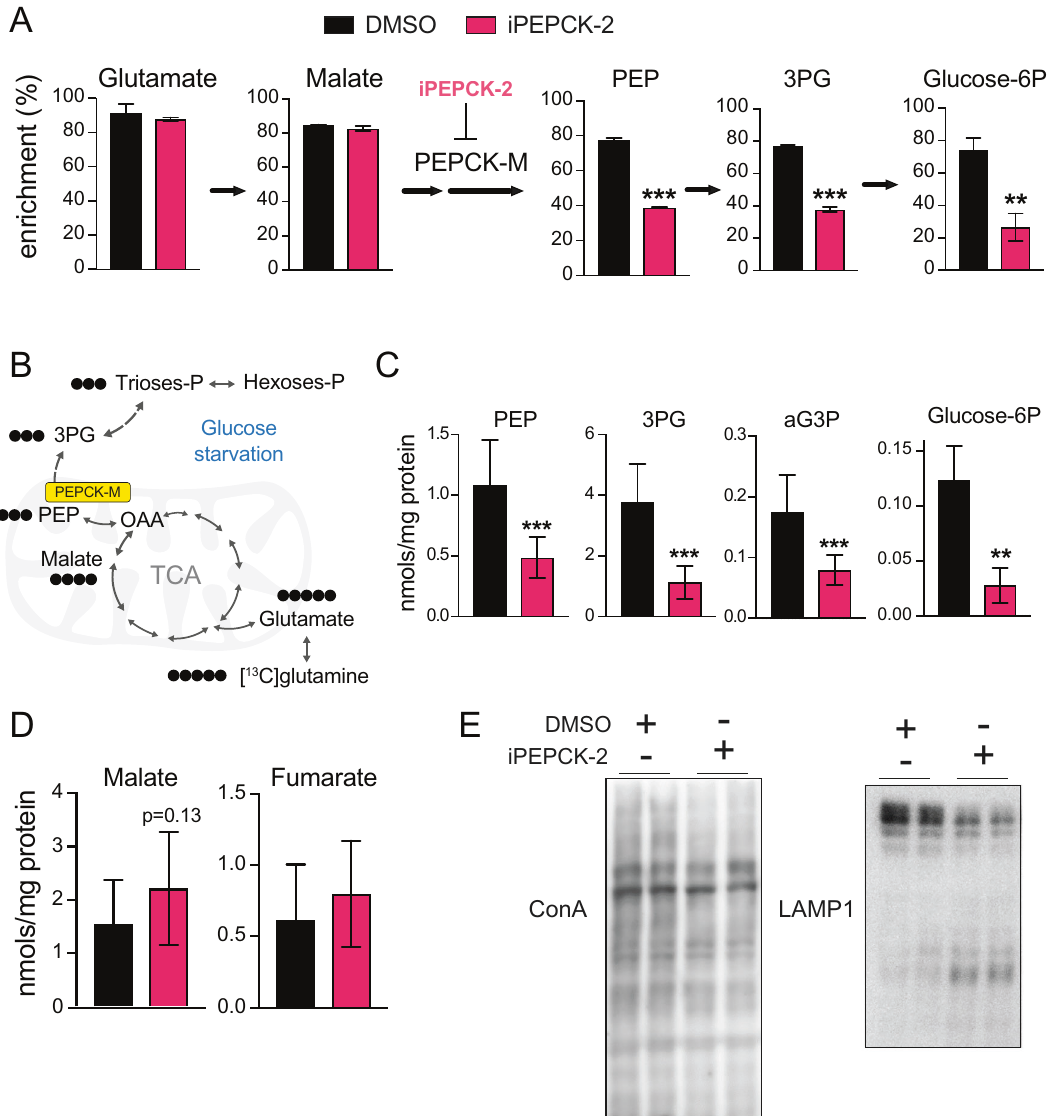
Fig. 4 Pharmacological inhibition of PEPCK-M blunts the capacity of the cell to fi ll-up the glycolytic intermediary pool of metabolites impacting on glycosylation. A Enrichment from 13 C-glutamine into glutamate, malate, phosphoenolpyruvate, 3-phosphoglycerate and glucose-6-phosphate in wild-type MCF7 cells grown in 0 mM glucose media in the presence of iPEPCK-2 (5 µM) or vehicle (DMSO). Metabolites were analyzed using GC/MS spectrometry. (Two-tailed t -test; n = 3). B Scheme of carbon fl ux from 13C-glutamine into glycolytic pathway. C Concentration of selected glycolytic intermediates in wild-type MCF7 cells grown 72 h in 0 mM glucose media in the presence of iPEPCK-2 (5 µM) or vehicle (DMSO). Metabolites were analyzed using GC/MS spectrometry (Two-tailed t -test; n = 3). D Concentration of selected glycolytic intermediates in wild-type MCF7 cells grown 72 h in 0 mM glucose media in the presence of iPEPCK-2 (5 µM) or vehicle (DMSO). Metabolites were analyzed using GC/MS spectrometry (Two-tailed t -test; n = 3). E Western blot for (top panel) Concanavalian A developed proteins, and (bottom panel) human LAMP1 showing full size protein and smeared bands of lower molecular weight representing partially glycosylated protein, after culturing the cells in the absence of glucose in the presence of iPEPCK-2 (5 µM) or vehicle